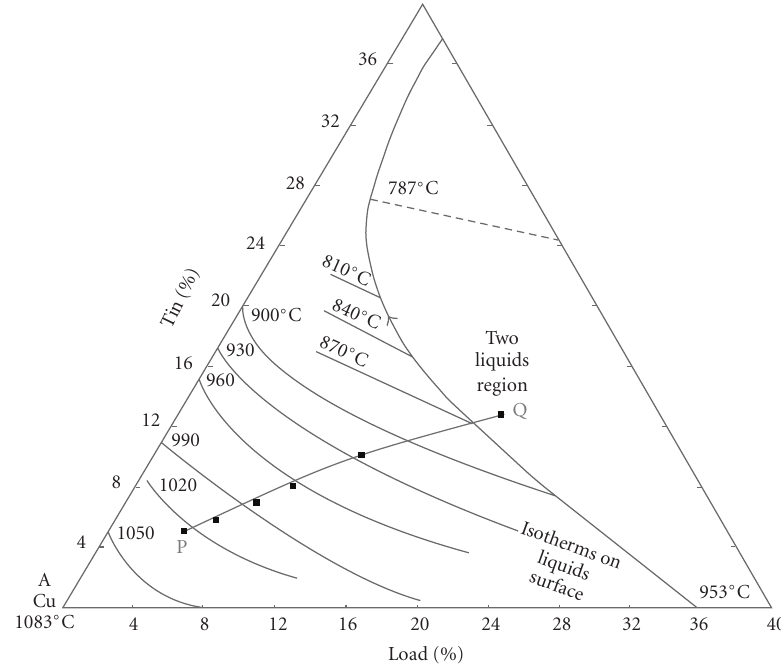
Figure 7: Liquidus surface of the copper–tin-lead ternary system [4].